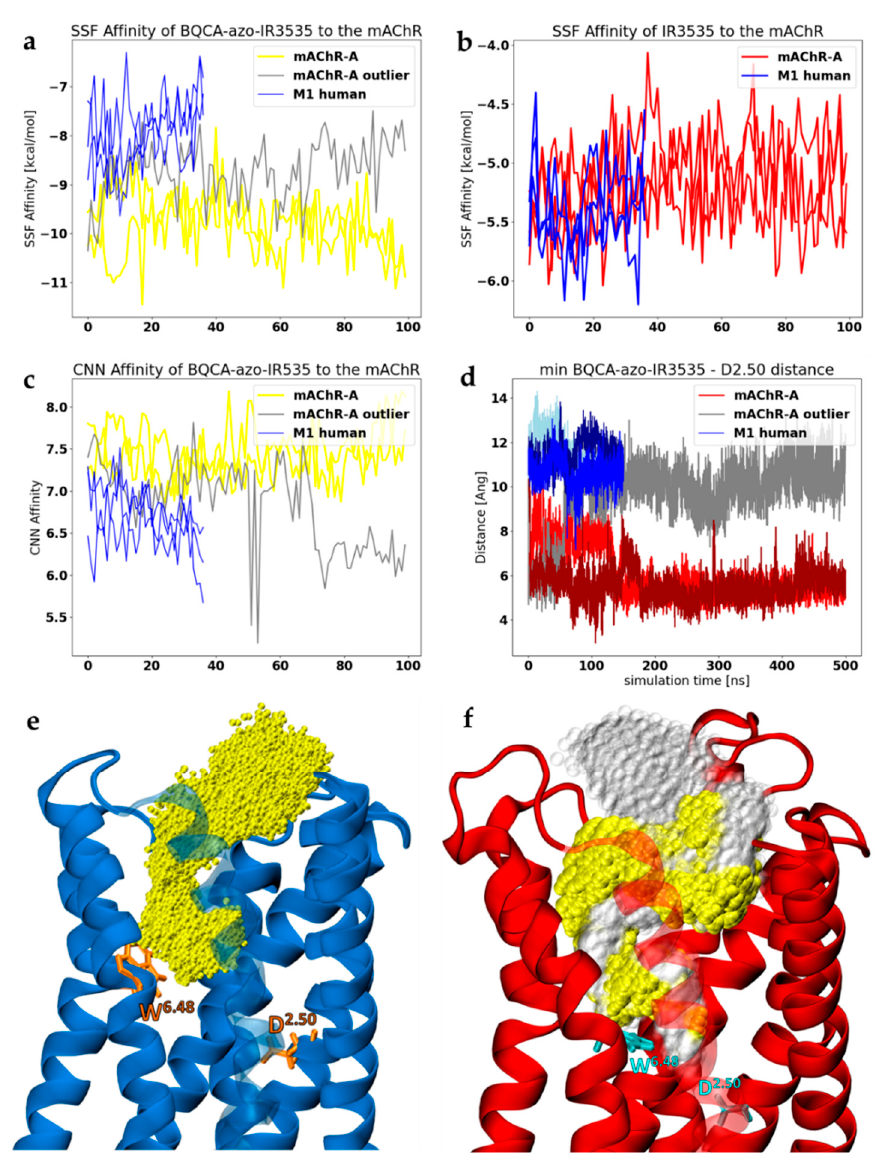
Figure 9. BQCA-azo-IR3535 interaction with mAChRs. The SSF affinity evolution for bitopic ligand ( a ) and IR3535 ( b ) are shown for mAChR-A and, for the reference, for the human M1 receptor. ( c ) The convolutional neural network (CNN) scoring function, measured in “pK” units where 1 µ M is 6, 1 nM is 9, is plotted for BQCA-azo-IR3535 interaction with mAChRs. ( d ) The distance [Å] between the closest non-hydrogen atom of a ligand and the D 2.50 residue (sodium pocket) of human M1 (blue) and insect mAChR-A (red and grey). ( e , f ) Positions occupied by non-hydrogen atoms of BQCA-azo-IR3535 (yellow) in the human M1 receptor ( e ) and insect mAChR-A model ( f ). The W 6.48 and D 2.50 residues are marked (orange in human and cyan in insect mAChR) as indicators of the distance between ligand OS and the sodium ion-binding site. For all plots, data collected from the 3 × 500 ns MD simulation for the human M1 receptor and 3 × 500 ns for the insect mAChR-A are shown.